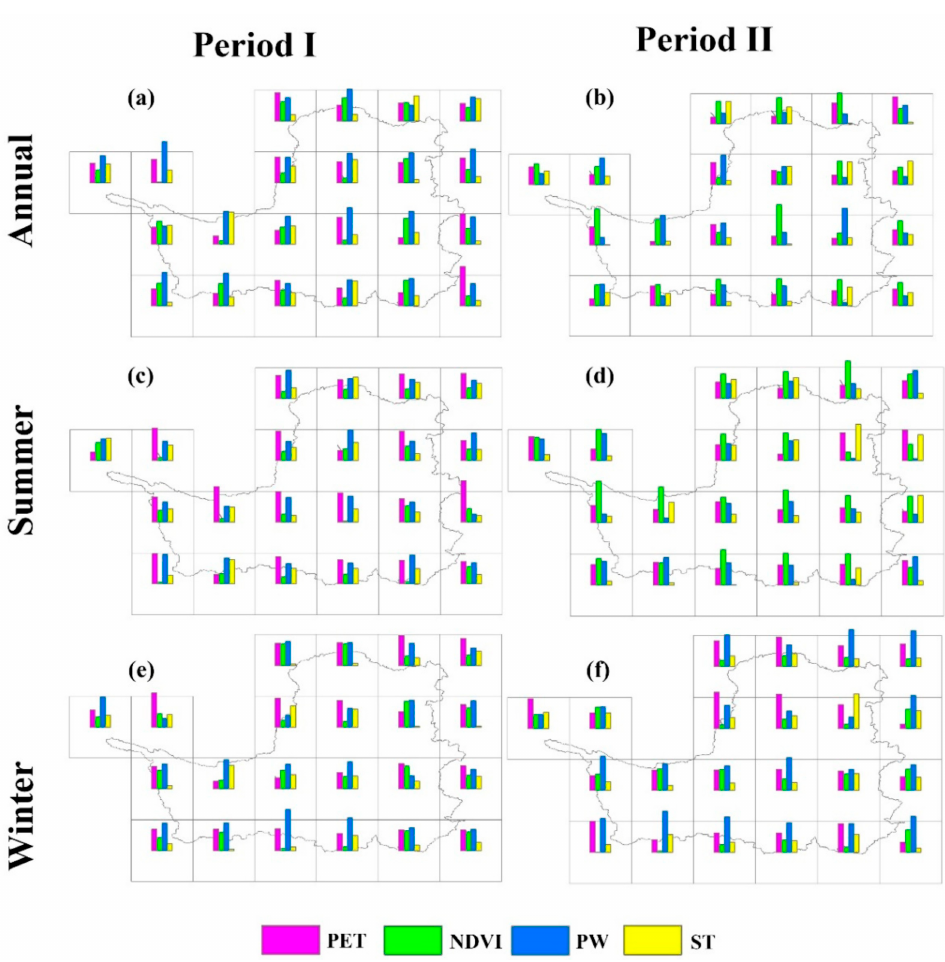
Figure 10. The influence degree of factors to annual precipitation in Period I ( a ) and Period II ( b ) in 22 subregions. The influence degree of factors to summer precipitation in Period I ( c ) and Period II ( d ). The influence degree of factors to winter precipitation in Period I ( e ) and Period II ( f